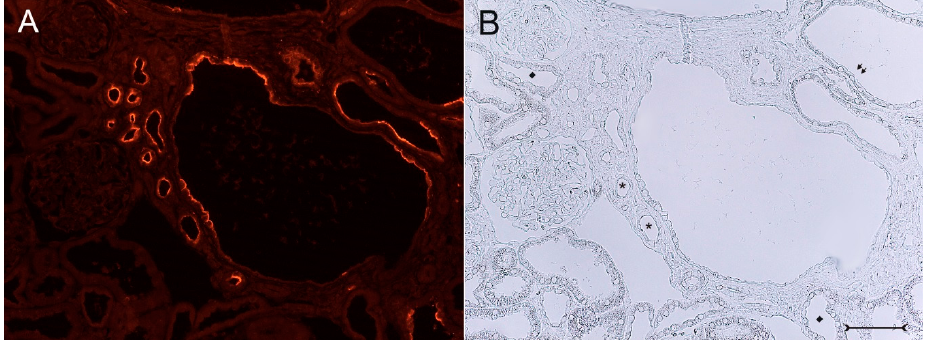
Figure 3. Kim-1 immunohistochemistry with fluorescent staining ( A ), (cy/+) rat kidney cortex; ( B ) corresponding phase contrast image. A mosaic-like expression pattern of Kim-1 in cyst wall epithelia of a large cyst (in the middle) with apically-concentrated labeling is seen; virtually all cells of this cyst are devoid of a brush border and show different morphologies. Small atrophic proximal tubuli (examples are marked with stars in ( B )) in the vicinity of the central cyst are Kim-1 positive, have markedly lost their brush borders and are surrounded by a compacted, fibrosed interstitium. Distal tubules (examples are marked with diamonds in ( B )) are devoid of a signal. Parts of the cystic profiles with a maintained brush border (see arrows, upper right in ( B )) do not express Kim-1. Bar = 75 µm.